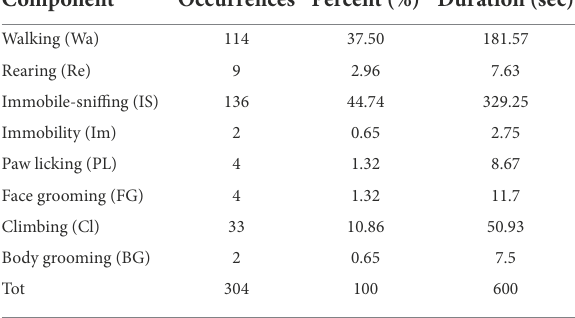
TABLE 1 Synoptic table summarizing occurrences, percent distribution and duration of behavioral units listed in the first column (abbreviations in brackets) and illustrated by means of event plot in Figure 1